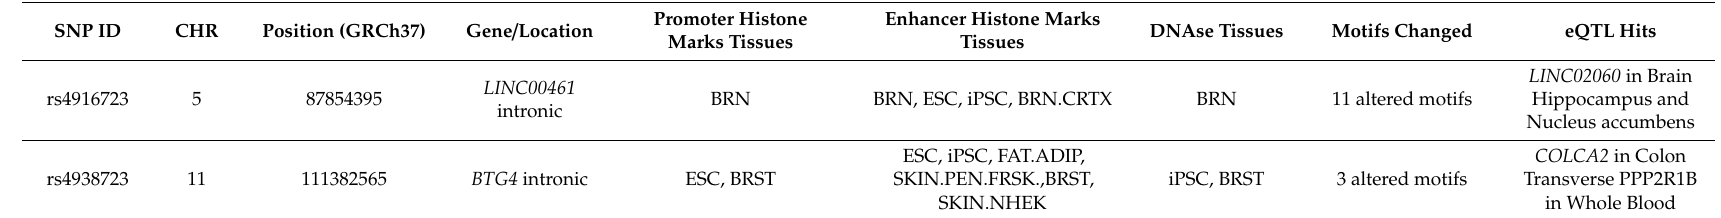
Table 3. Single nucleotide polymorphism (SNP) regulatory information available in Haploreg v4.1.